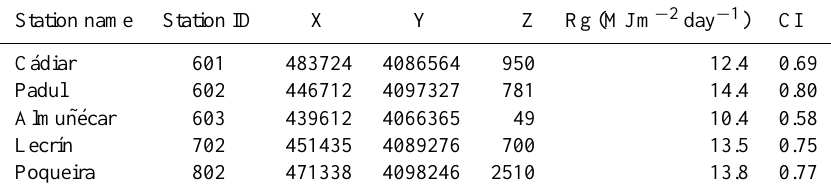
Table 1. UTM coordinates of the weather stations, measured daily global radiation and clearness index on the 20 November